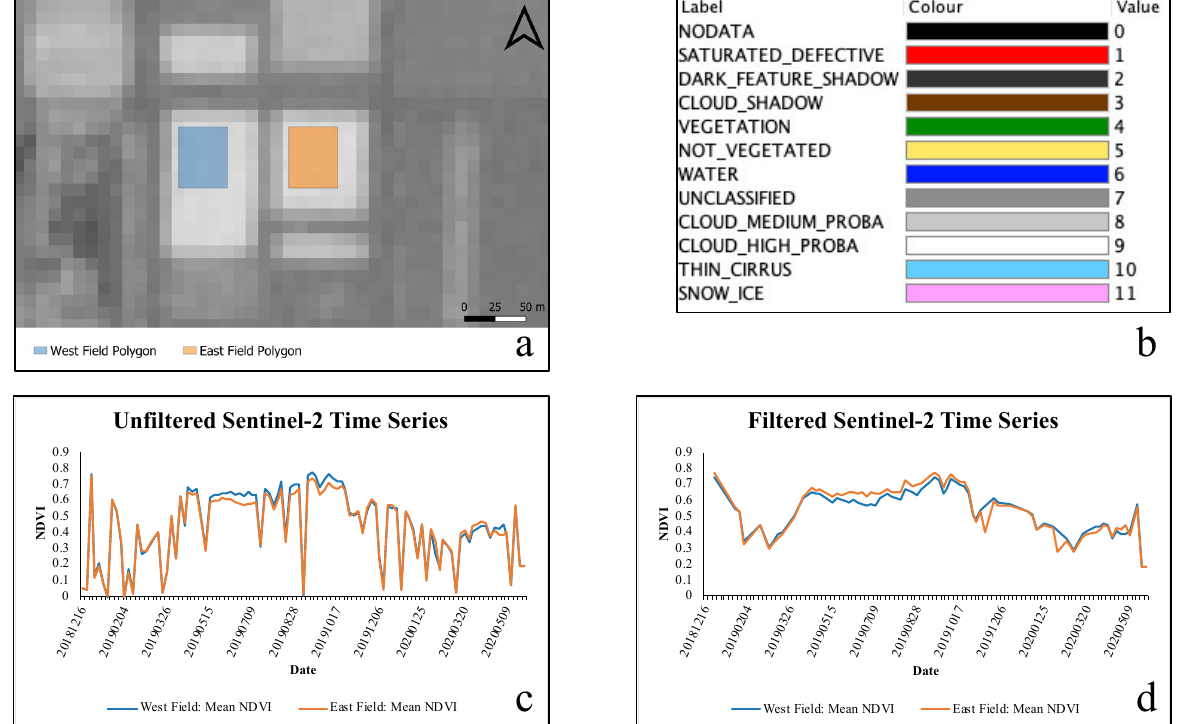
Figure 7. An NDVI grayscale Sentinel-2 image dated 26 December 2018, with the east and west fields shown for illustration ( a ). Satellite data were filtered to remove cloud-impacted imagery using the Sentinel-2 scene classification layer (SC), which categorizes pixels into 12 distinct classes ( b ). Unfiltered ( c ) and filtered ( d ) time series data depicting mean pixel NDVI were extracted from Sentinel-2 ARD.